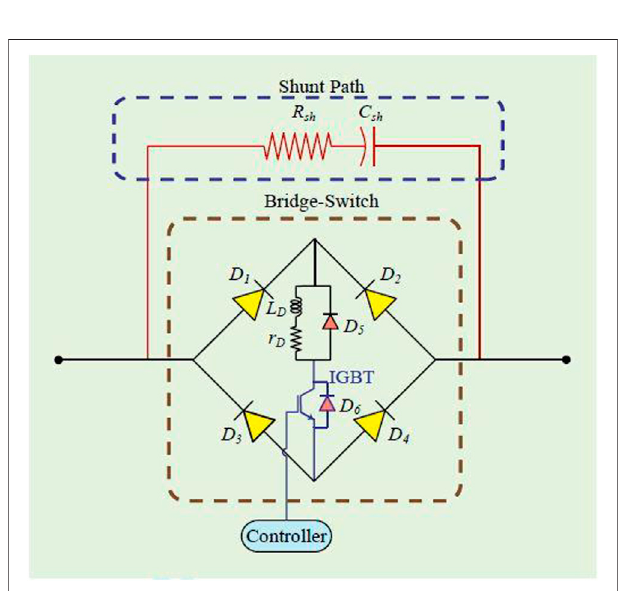
FIGURE 5 | Control structure of the CBFCL in the PMSG wind turbine.